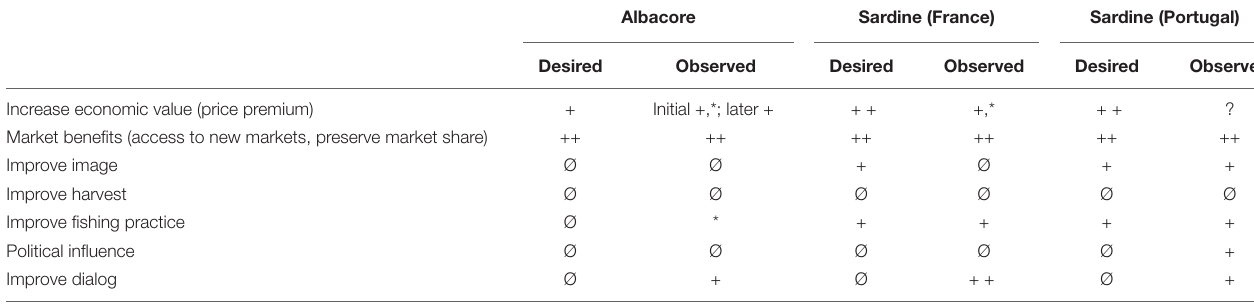
TABLE 3 | Summary of reported desired and observed outcomes from MSC